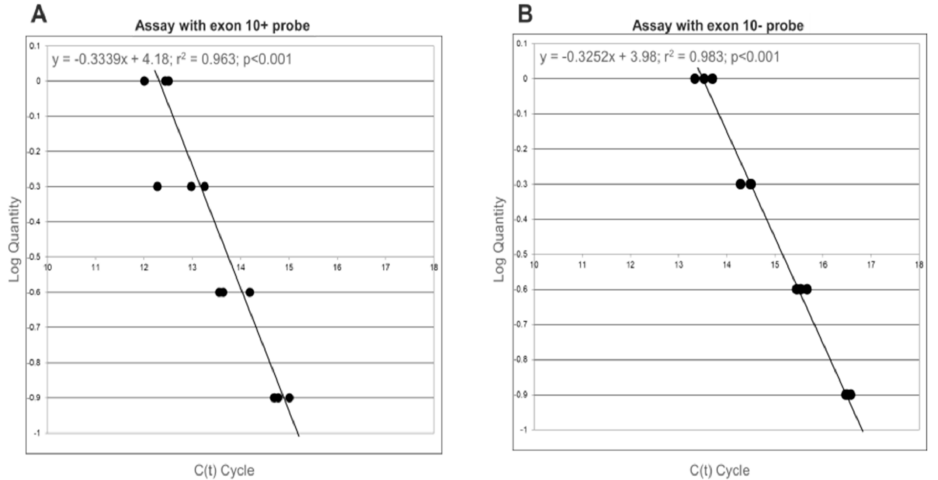
Figure 1. Efficiency curve for exon 10+ and exon 10 − plasmid assays. ( A ) The efficiency of probe at junction exon 9—exon 10 is calculated using different concentrations of plasmid with exon 10 (assay with 10+ probe). ( B ) The efficiency of probe at junction exon 9—exon 11 is calculated using different concentrations of plasmid without exon 10 (assay with 10 − probe). For both, the efficiency curve is obtained evaluating the logarithmic quantity in respect to the Ct